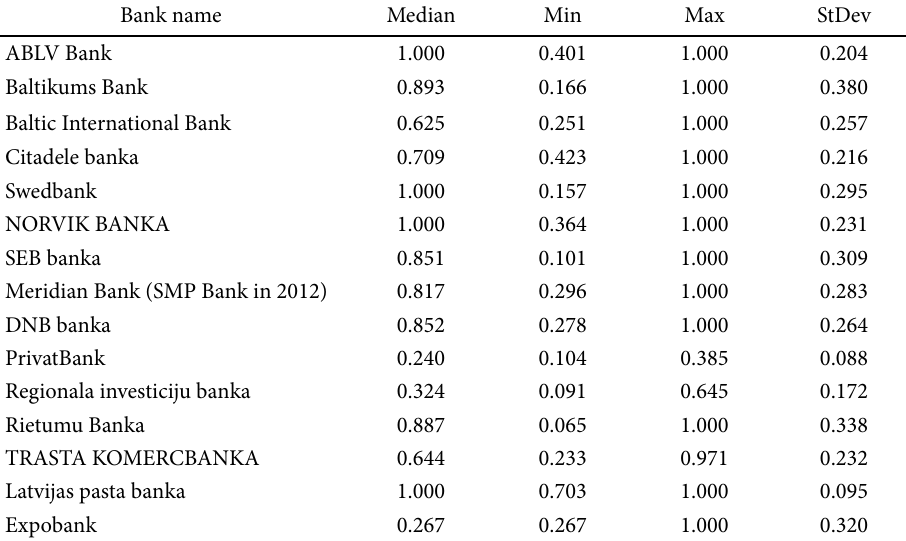
Table 9. Efficiency of Latvian banks calculated with M1-M14 models: descriptive